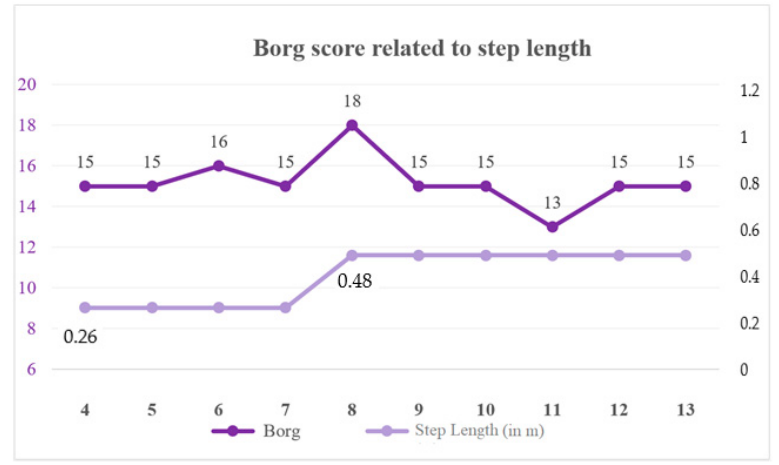
Scheme 1. Relation between the Borg score and the length of the step of the movement map used during the session. Table 2. Skills per session.